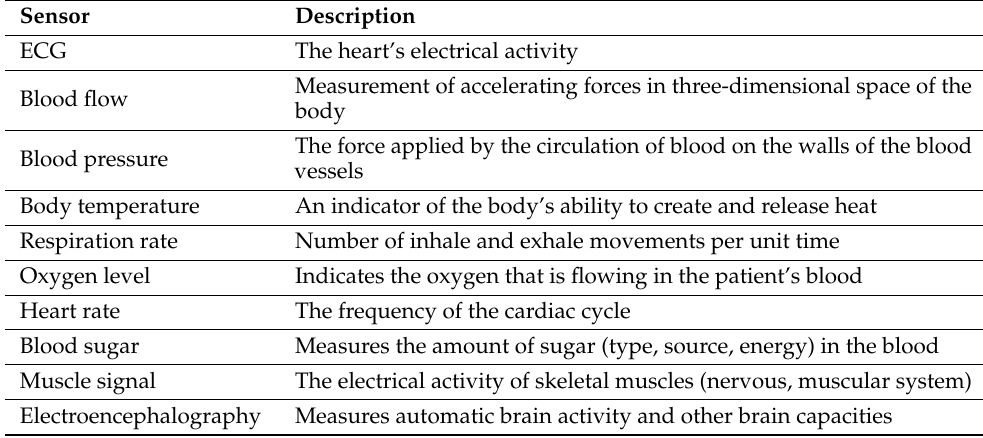
Table 1. Various medical sensors deployed on the human body [7,19,25].